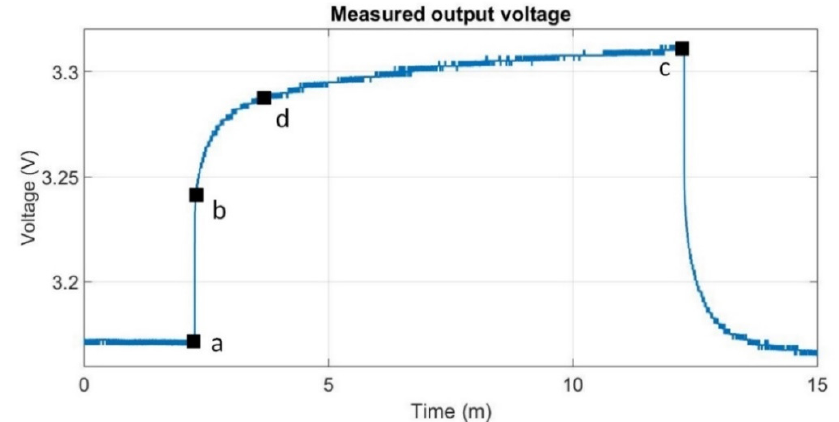
Figure A1. Measured points to calculate parameters 𝑅 (cid:2868) , 𝑅 (cid:2869) and 𝐶 (cid:2869) at 80% of SOC